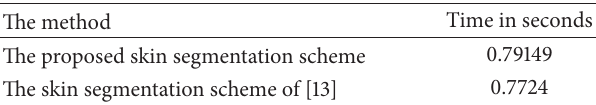
Table1:Comparisonbasedoncomputationaltimeforskinsegmen- tation